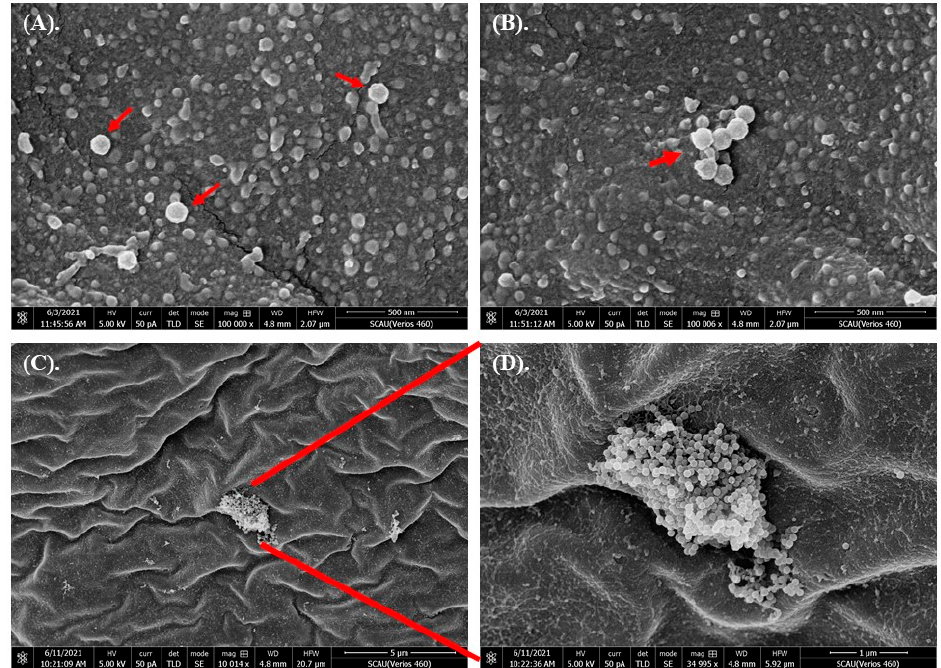
Figure 2. SEM images of the out-membrane surface of grass carp embryo after exposed to 80 nm microplastics. ( A – C ) show different status of microplastics on membranes. ( D ) is a larger version of ( C ).